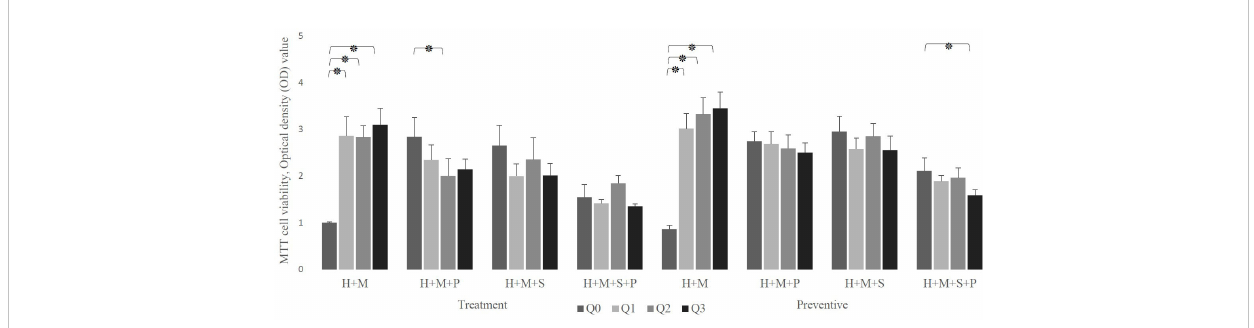
FIGURE 5 The effect of the presence of Q10 on the viability of infected H (HEp-2 cell) treated with probiotics (P , L. plantarum ; S, L. salivarius ) in the treatment and preventive mode. The presence of Q10 at all doses leads to the prevention and treatment of HEp-2 cells. Also, co-treatment of these cells with Q10 and probiotics at some doses and prevention at all doses preserves their viability. The values are the mean ± SD of these assays. Asterisk (*) indicates a signi fi cant difference (p-value<0.05) in the values when compared to the control. (Q0, absence Q10; Q1, 1 m g Q10; Q2, 5 m g Q10; and Q3, 10 m g